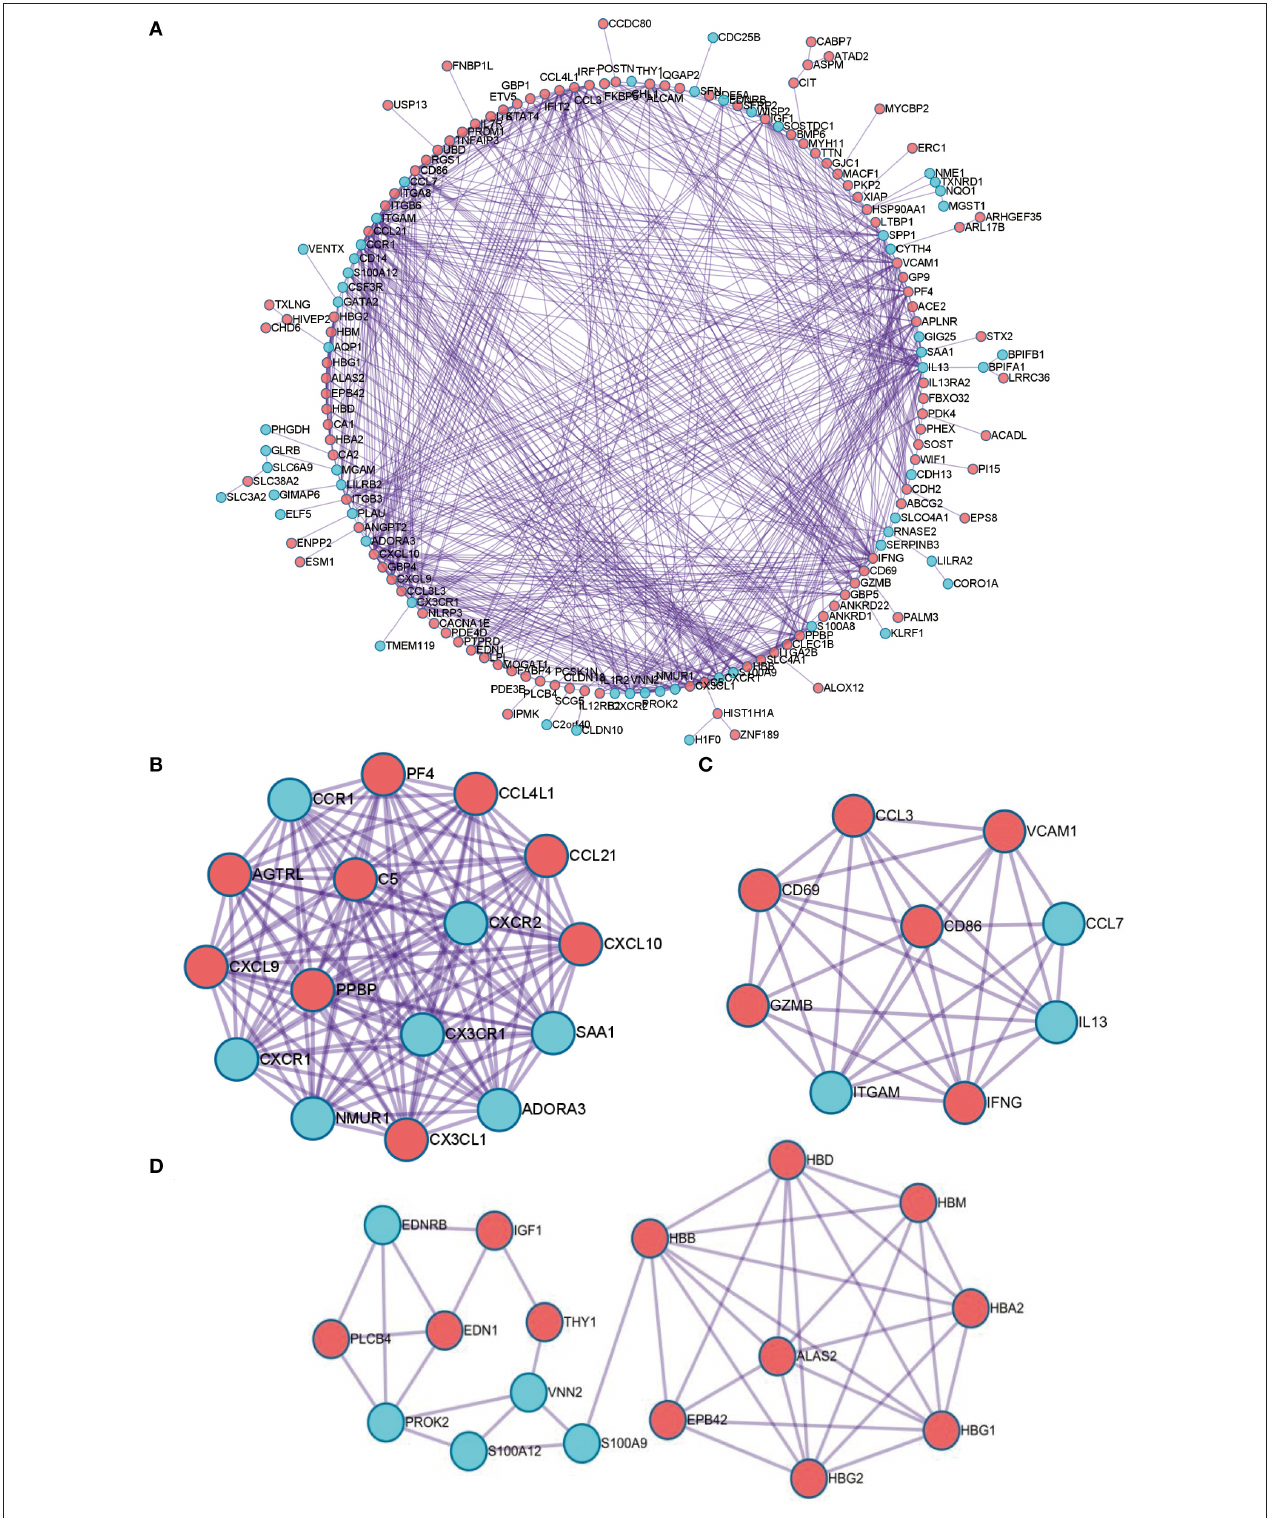
FIGURE 4 | The PPI network of the robust DEGs. (A) PPI network of upregulated and downregulated significant genes. (B–D) The most significant modules identified through MCODE in Cytoscape software. PPI, protein–protein interaction; DEG, differentially expressed gene.